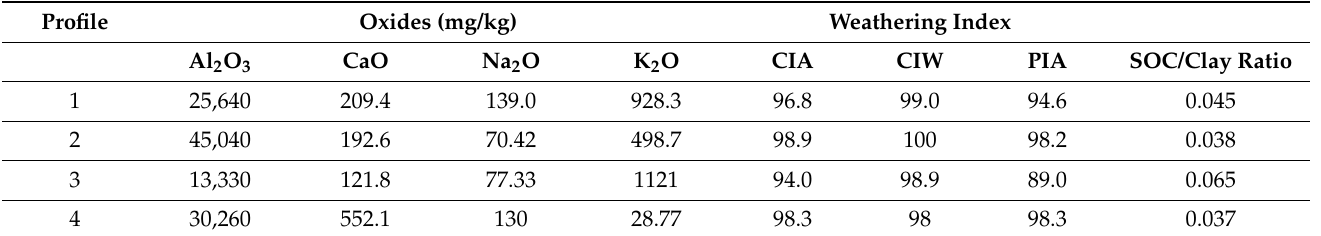
Table 5. Evaluation of the geochemical weathering indices in surface